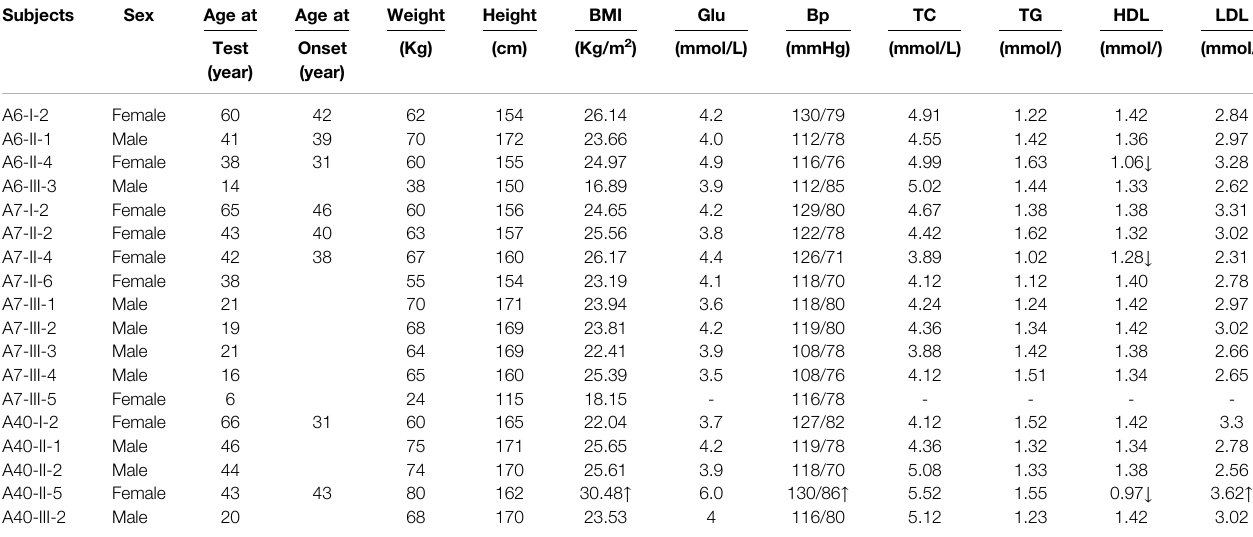
TABLE 1 | Summary of the clinical data for eighteen maternal relatives in three Han Chinese cholecystolithiasis pedigrees.